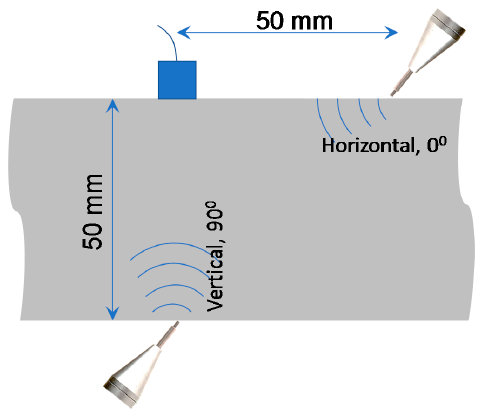
Figure 12. Experimental setup showing the receiver at the top concrete surface and pencil lead breakage applied at the horizontal and vertical direction.